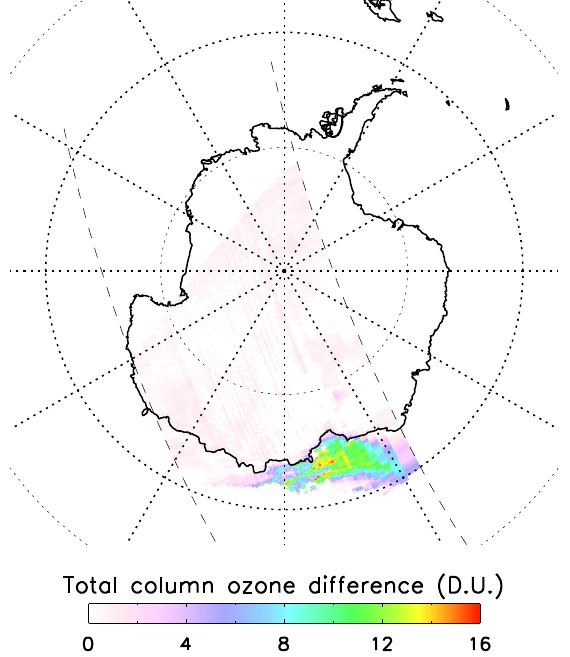
Fig. 12. OMTO3 V8.5 total column ozone retrieved for OMI orbit 12394. Fig. 11. Column ozone difference between the retrievals with OMI-derived scene pressures and those from the OMTO3 V8.5 algorithm for OMI orbit 12394. 32 31